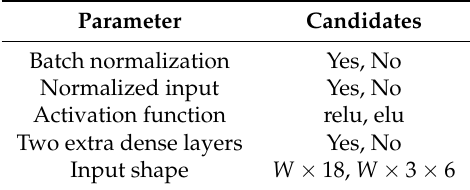
Table 4. Parameters of the grid search for the repetition counting